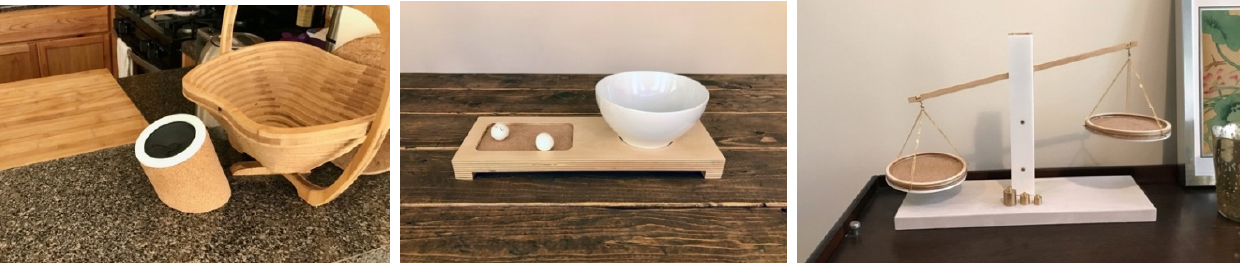
Figure 6. From left to right, the Cohousing Radio, Physical RSVP, and Participation Scales.